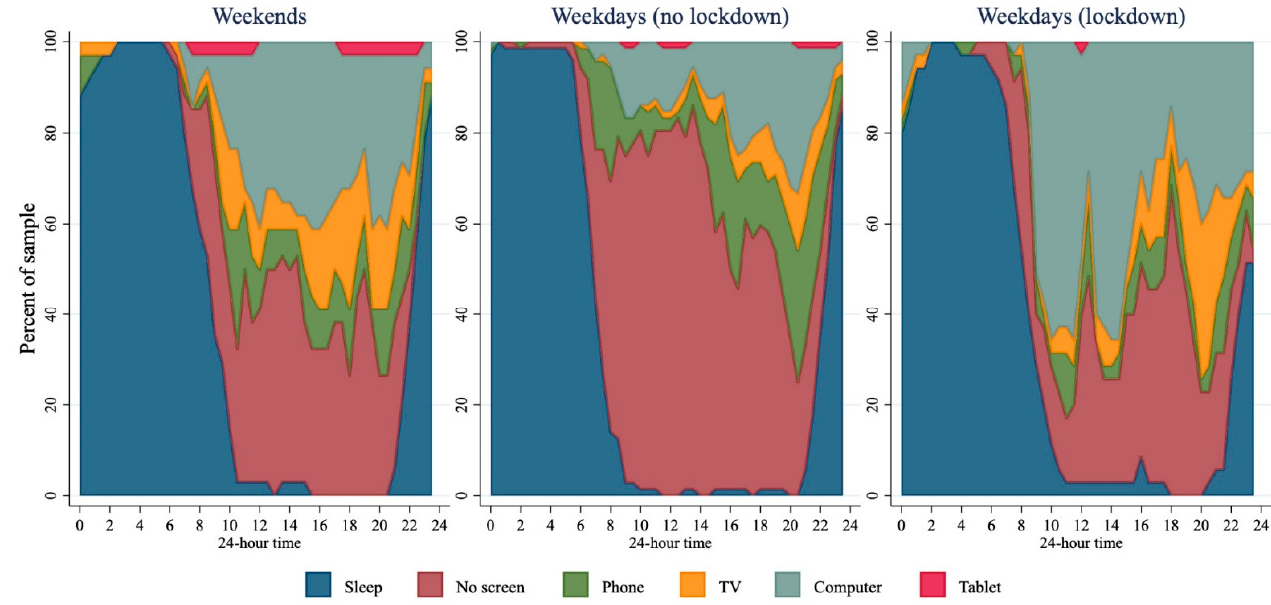
Figure 4. Screen use across 24 h for weekends ( n = 34), weekdays before lockdown ( n = 72), and weekdays during lockdown ( n = 35). If multiple screens in use then the one they were interacting with most was prioritised.